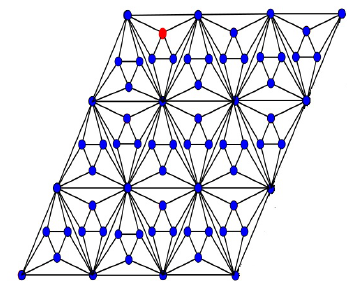
Figure 4. Third type of rectangular hex-derived network ( RHDN 3 ( 4,4 )